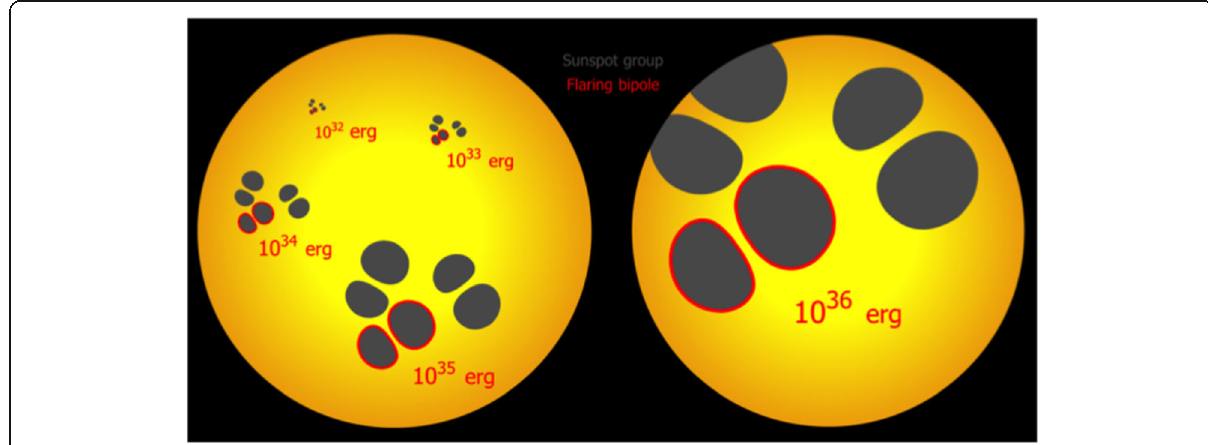
Fig. 7 Schematic representation of several modeled sunspot groups on the solar disk, with their corresponding modeled flaw energies computed with the Aulanier et al. (2013) simulation. A sunspot group consists of several pairs of sunspots. In each group, a pair of sunspots (surrounded by red curve) representing 30% of the sunspot group area is modeled in the simulation (taken from Schmieder